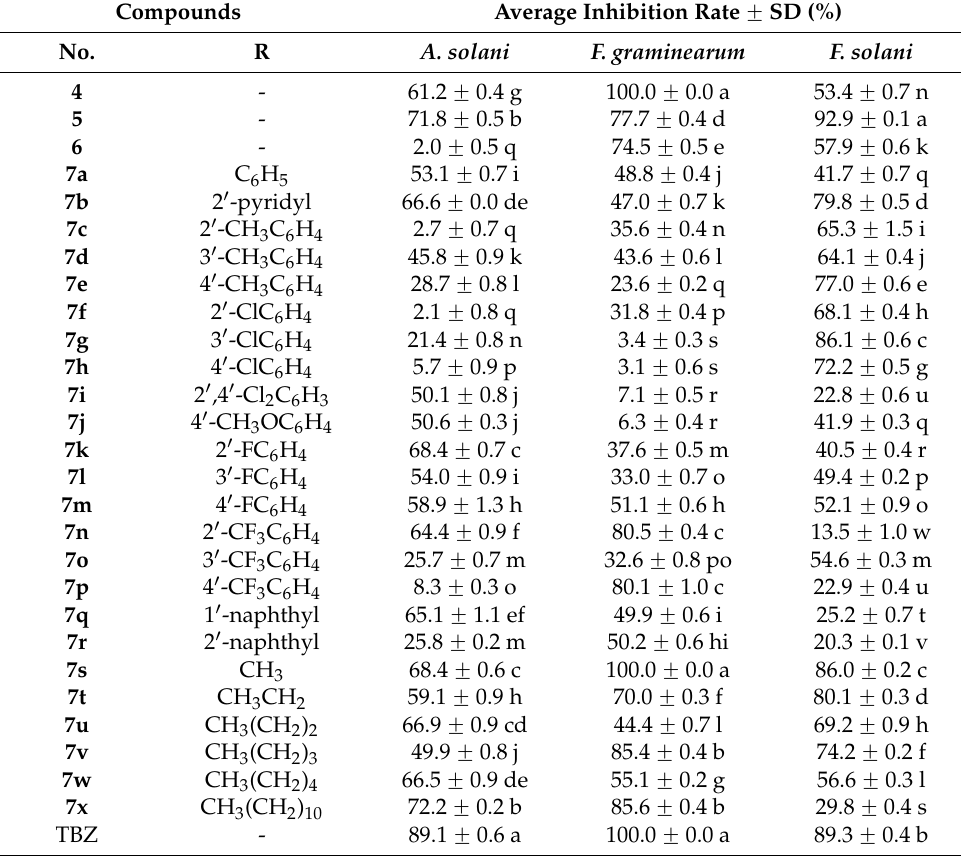
Table 1. Average inhibition rates of compounds 4 – 6 and 7a – 7x against three phytopathogenic